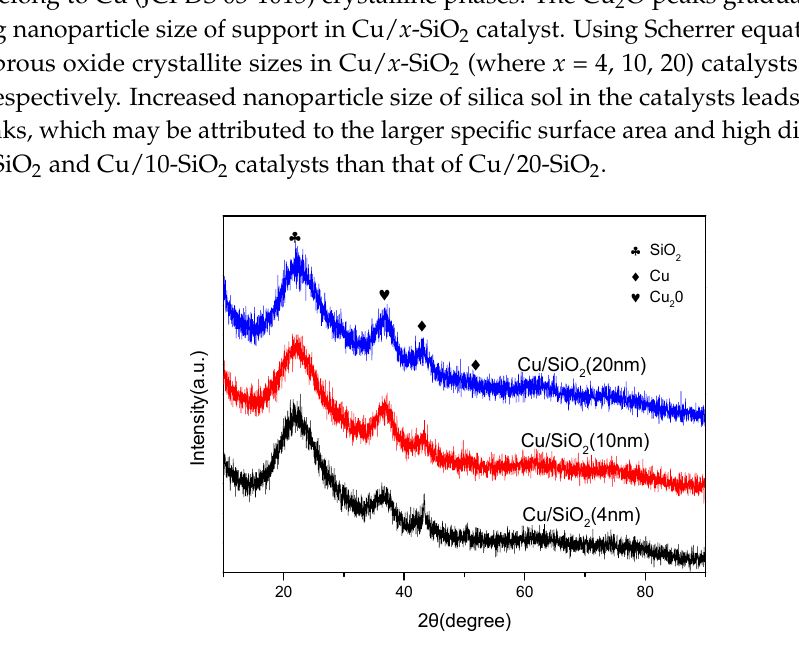
Figure 3. The x-ray diffraction (XRD) patterns of the reduced catalysts.